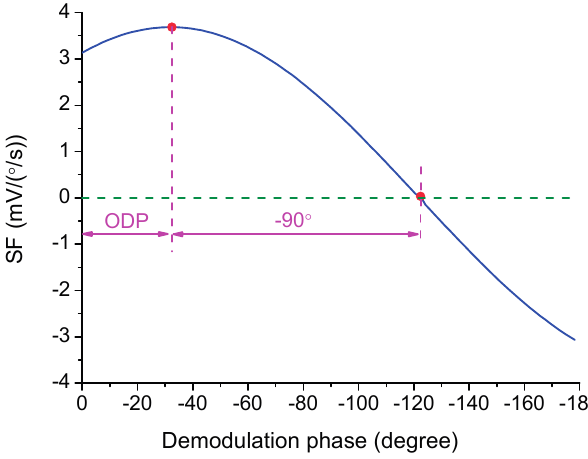
Figure 11. The relationship between the scale-factor and the demodulation